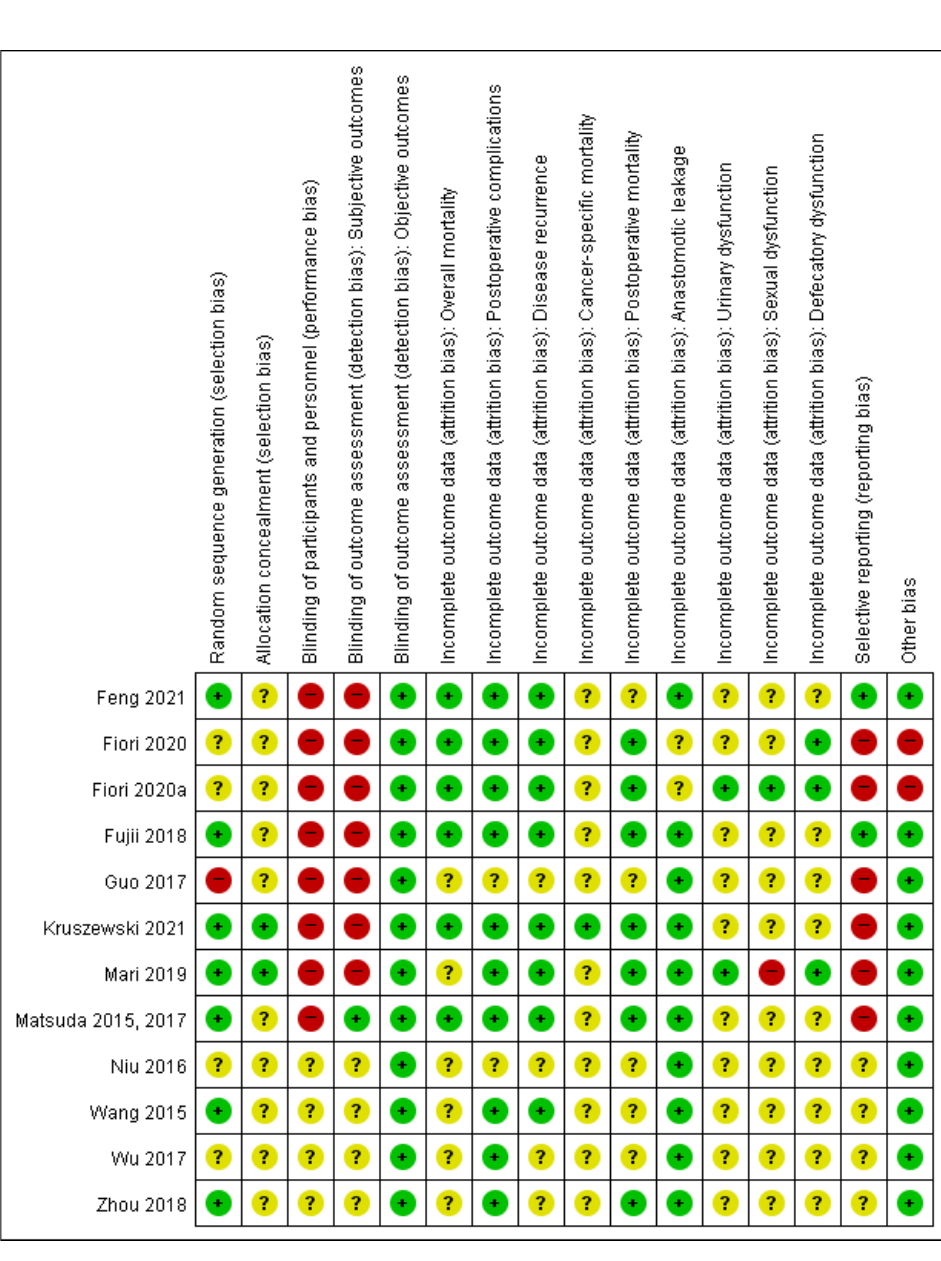
Figure 6. Risk of bias summary: Review authors’ judgments about each risk of bias item for each included study. Subjective outcomes: Postoperative complications, anastomotic leakage, urinary dysfunction, sexual dysfunction, and defecatory dysfunction. Objective outcomes: Overall mortality, disease recurrence, cancer-specific mortality, and postoperative mortality. Categories: Green point (+) = low risk of bias; yellow point (?) = unclear risk of bias; red point (-) = high risk of bias.